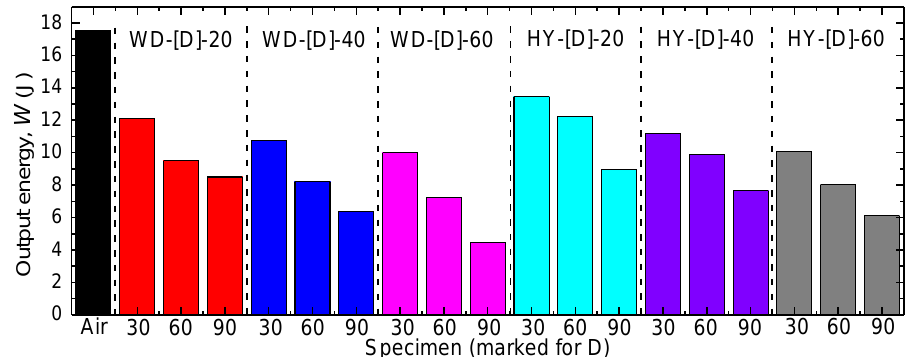
Figure 11. Output energy of loading machine before fracture occurred.